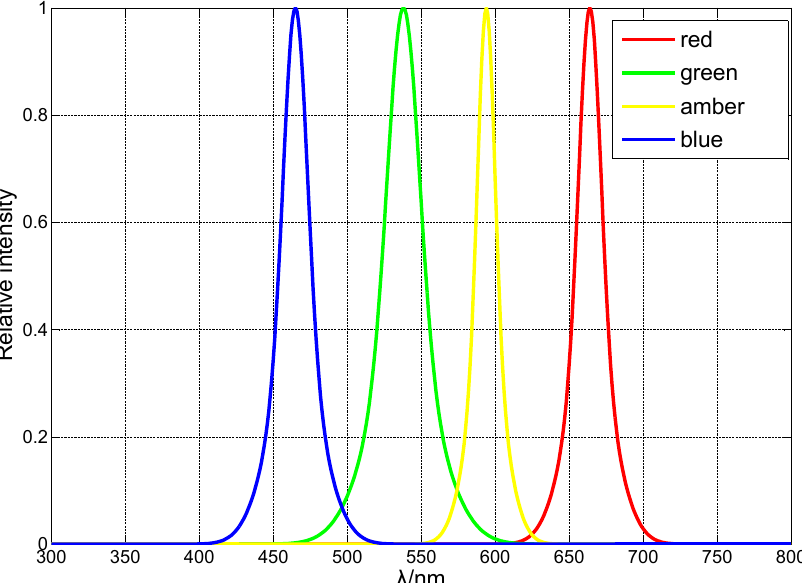
Figure 2. Spectral model for the quadrichromatic LED (QLED) with red/amber/green/blue (RAGB) colors. At the receiver side, equipped with the specific optical filters, the receiver PDs are used to